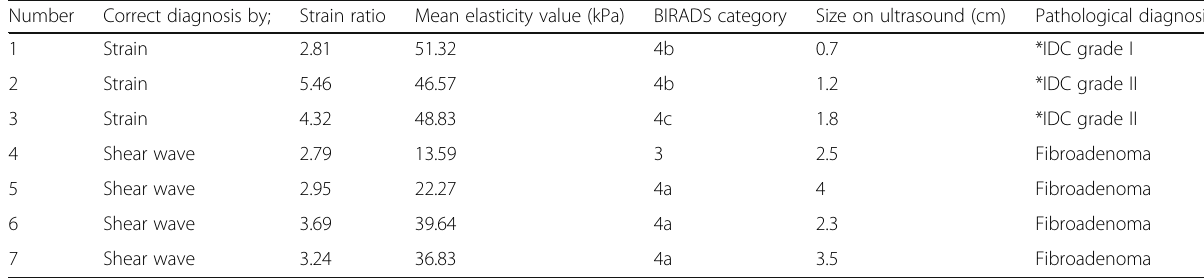
Table 2 Discrepant results of breast mass lesions at strain and shear wave elastography Number Correct diagnosis by; Strain ratio Mean elasticity value (kPa) BIRADS category Size on ultrasound (cm) Pathological diagnosis